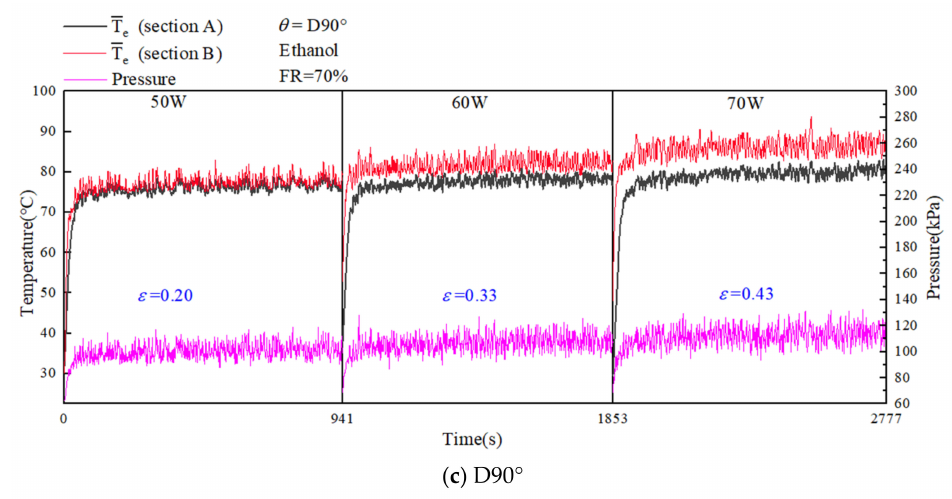
Figure 8. Variation of average temperature and internal pressure of evaporation section with time under different installation angles of ethanol working